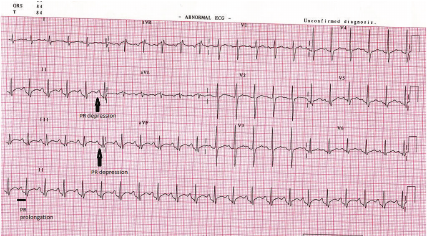
Figure 2: 12 lead ECG at the time of presentation showing sinus tachycardia, prolonged PR interval (220 msec), and PR segment depression (4